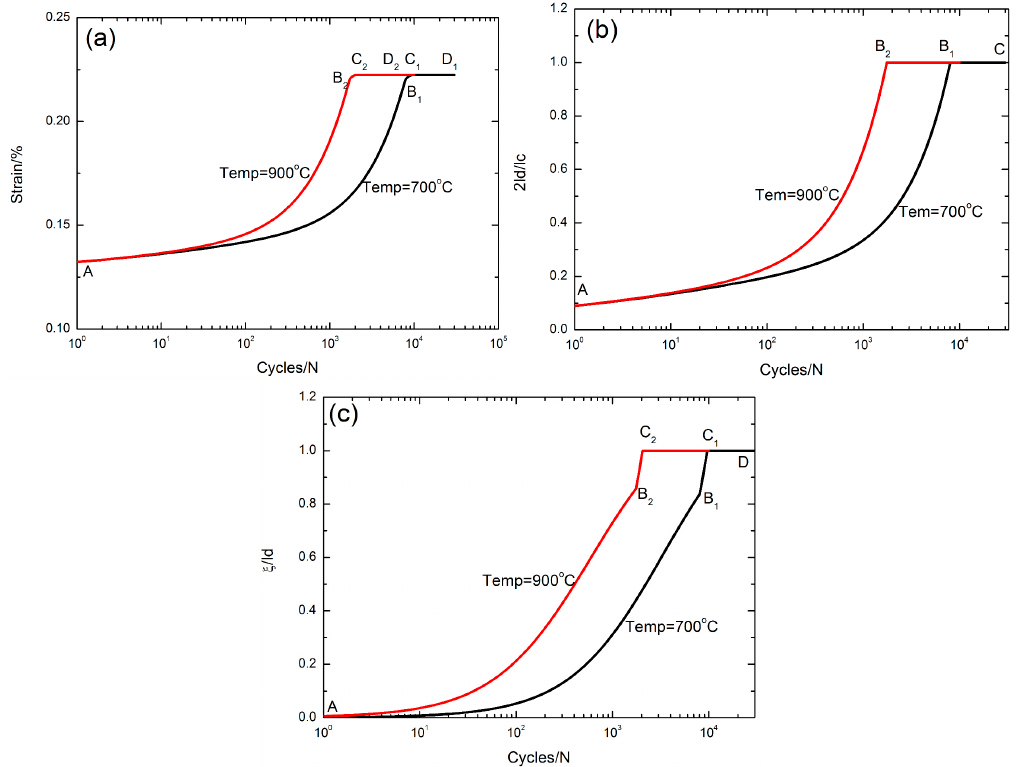
Figure 10. ( a ) The peak strain versus cycle number curves; ( b ) the interface debonded length 2 l d / l c versus cycle number curves; and ( c ) the interface oxidation length ξ / l d versus cycle number curves corresponding to different oxidation temperatures of Tem = 700 °C and 900 °C under σ max = 200 MPa with stress rupture time of 10 s.